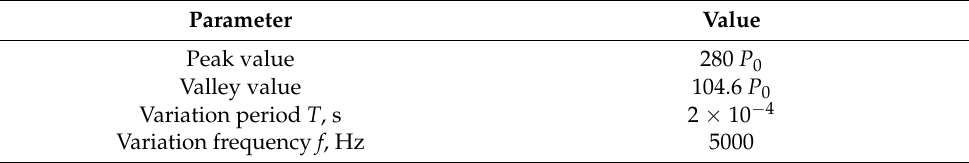
Table 3. Main parameters of P b .